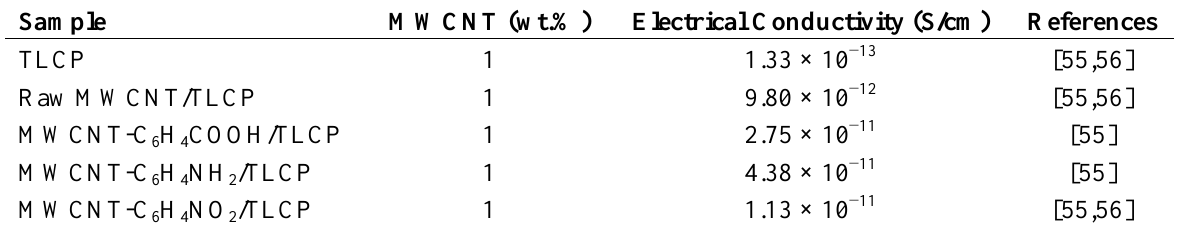
Table 3. Electrical conductivity of the MWCNT/TLCP nanocomposites. Sample MWCNT